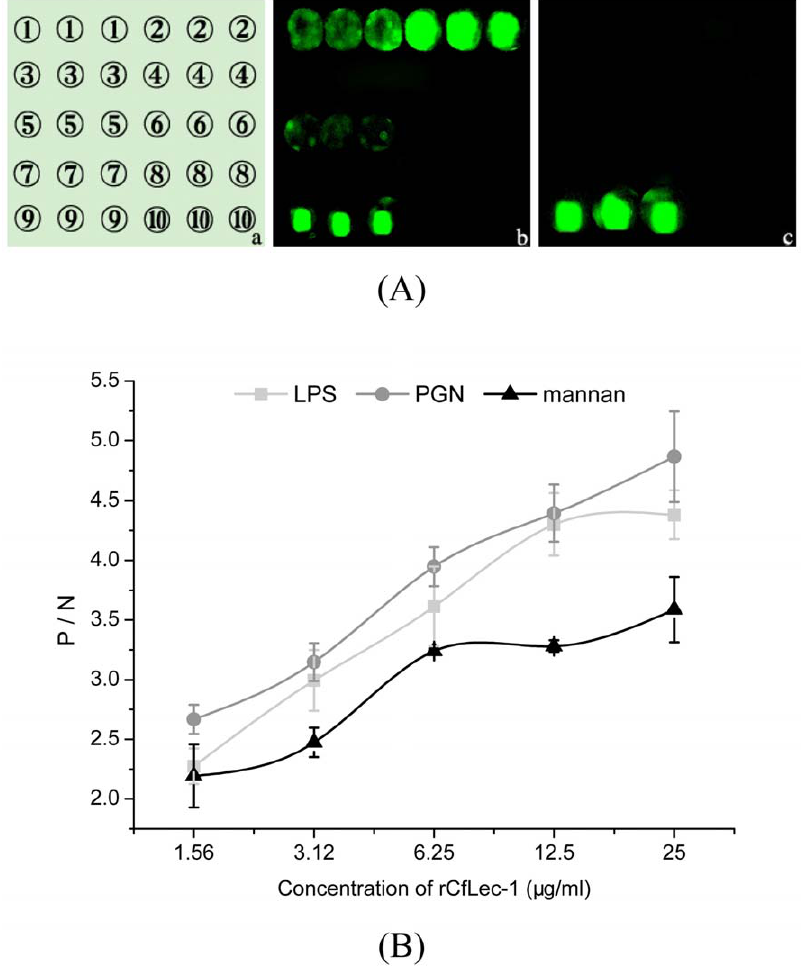
Figure 3. PAMPs binding assays. (A) PAMPs binding assay with microarrays. Samples were print onto the glass slides as the order showed in Table 2. The PAMPs microarrays were blocked by BSA, then rCfLec-1was added, and rTrx was set as a control. The interaction was detected by Cy3- conjugated anti-CfLec-1 antibody. (B) The dose-dependent of PAMPs binding by the method of ELISA. Plates were coated with 20 m g of PAMPs, respectively, which were washed and incubated with several concentrations of rCfLec-1 and rTrx in the presence of 5 mM CaCl 2 at 18 u C for 3 h and detected with rat polyclonal antiserum and goat-anti-rat Ig-alkaline phosphatase conjugate. Samples with P/N . 2.1 were considered positive. Results are representative of average three such experiments.